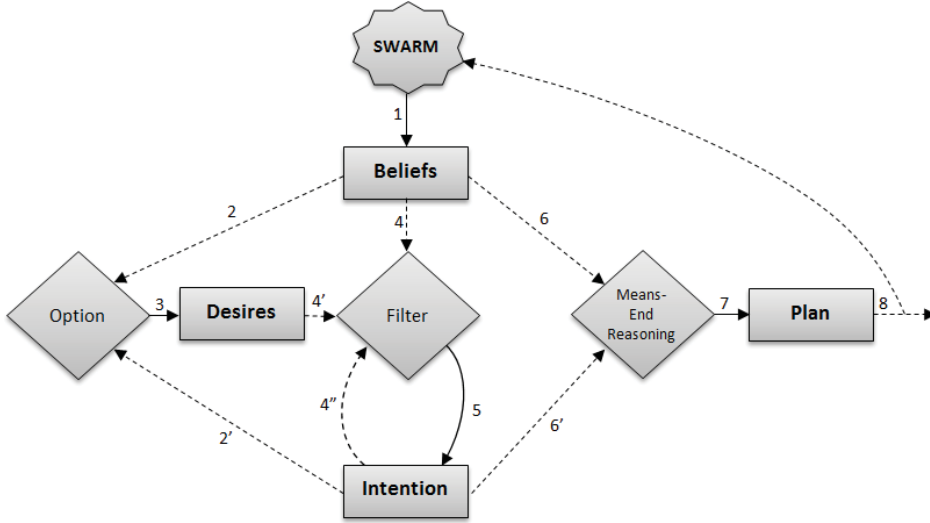
Figure 1: Particle’s Thought Process for Choice of